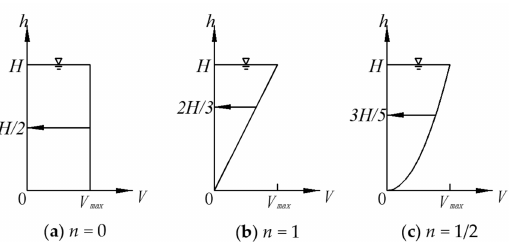
Figure 5. The flow velocity distribution curve and the joint force focus position of flowing water pressure: ( a ) n = 0; ( b ) n = 1; ( c ) n = 1/2.